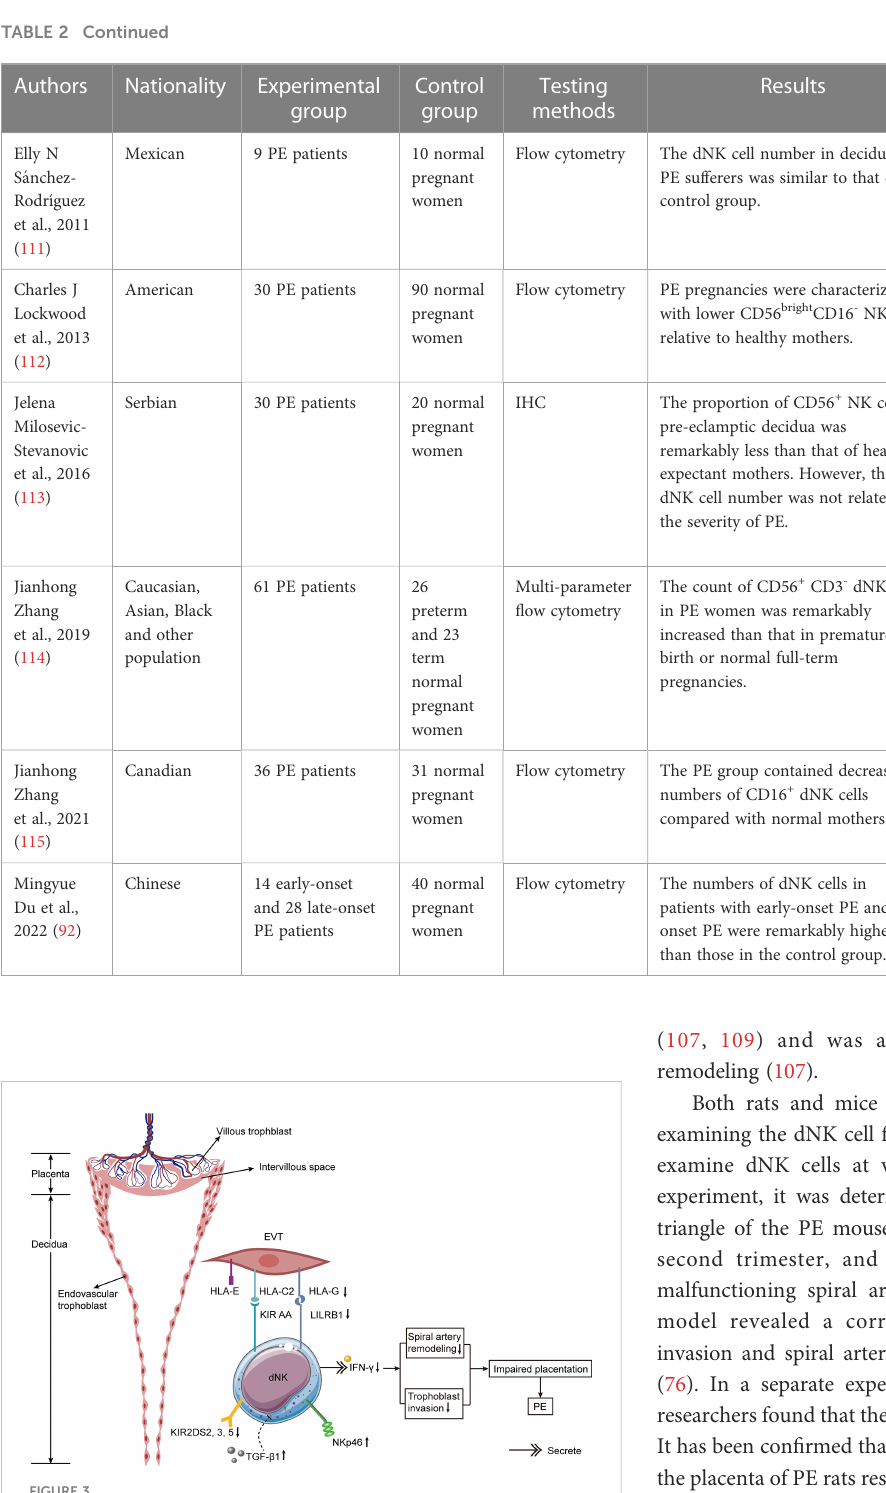
FIGURE 3 Hypothetical model of alternations of dNK cells in PE. The incidence of PE is signi fi cantly increased if the mother has KIR AA genotype and the trophoblast has HLA-C2. The expressions of activating KIR2DS2, 3, and 5 are decreased on dNK cells from PE patients. Besides, the expressions of HLA-G on trophoblast cells and its receptor LILRB1 on dNK cells are diminished in PE. The expression of NKp46 on dNK cells is elevated in PE. The increased expression of TGF- b 1 in decidua of females with PE suppresses the activation of speci fi c subpopulations of dNK cell, thus resulting in PE. Lower levels of IFN- g secreted by dNK cells result in defective spiral artery remodeling and abnormal trophoblast invasion, leading to impaired placentation and ultimately causing